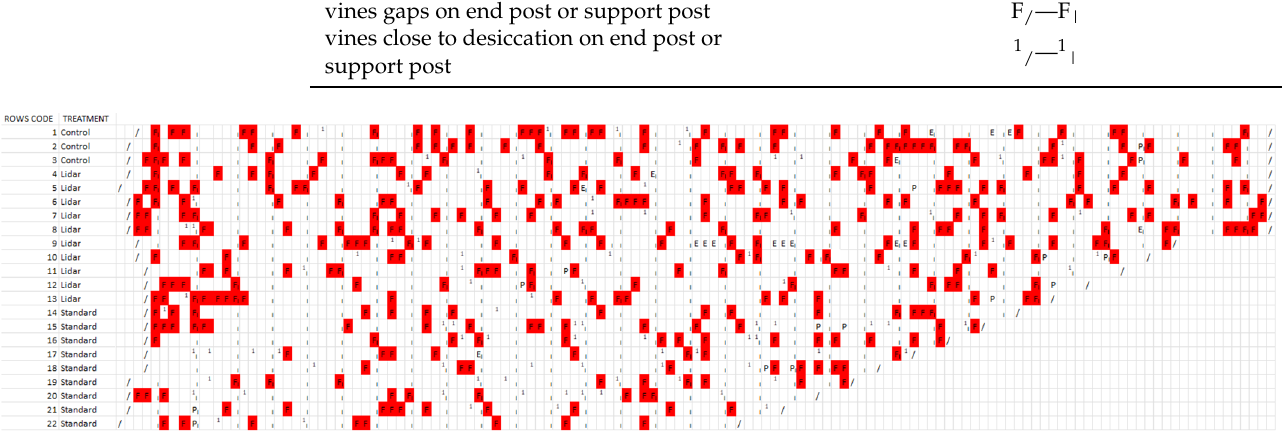
Figure 3. Vineyard mapping: each box responds to the ideal position of a grapevine, with different situations reported in Table 1.